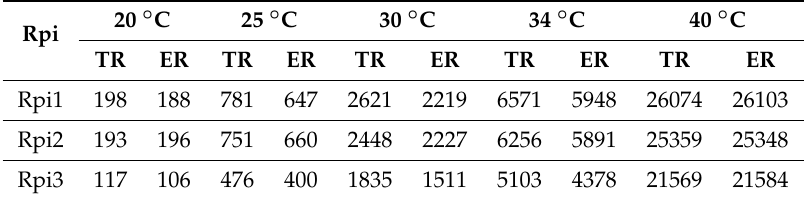
Table 1. The number of bit flips under temperature 20 ◦ C, 25 ◦ C, 30 ◦ C, 35 ◦ C, 40 ◦ C, where TR is the test results in thermal chamber and ER is the value evaluated by Equation (1).